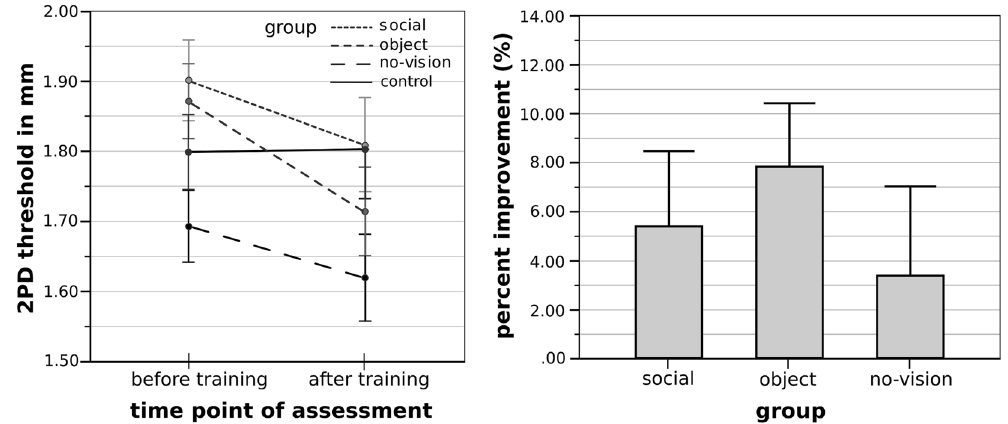
Figure 3. Effect of three hours of tactile coactivation on two-point discrimination thresholds. Left panel: Two-point discrimination thresholds of the three different groups of the initial training experiment (social, object, no-vision), and of the control group (control experiment 1) that did not receive training. Note that lower thresholds indicate better performance. Right panel: Bar plots show training effects (post – pre, in %) in two- point discrimination thresholds for the three groups of the initial training experiment. Shown are means and standard errors